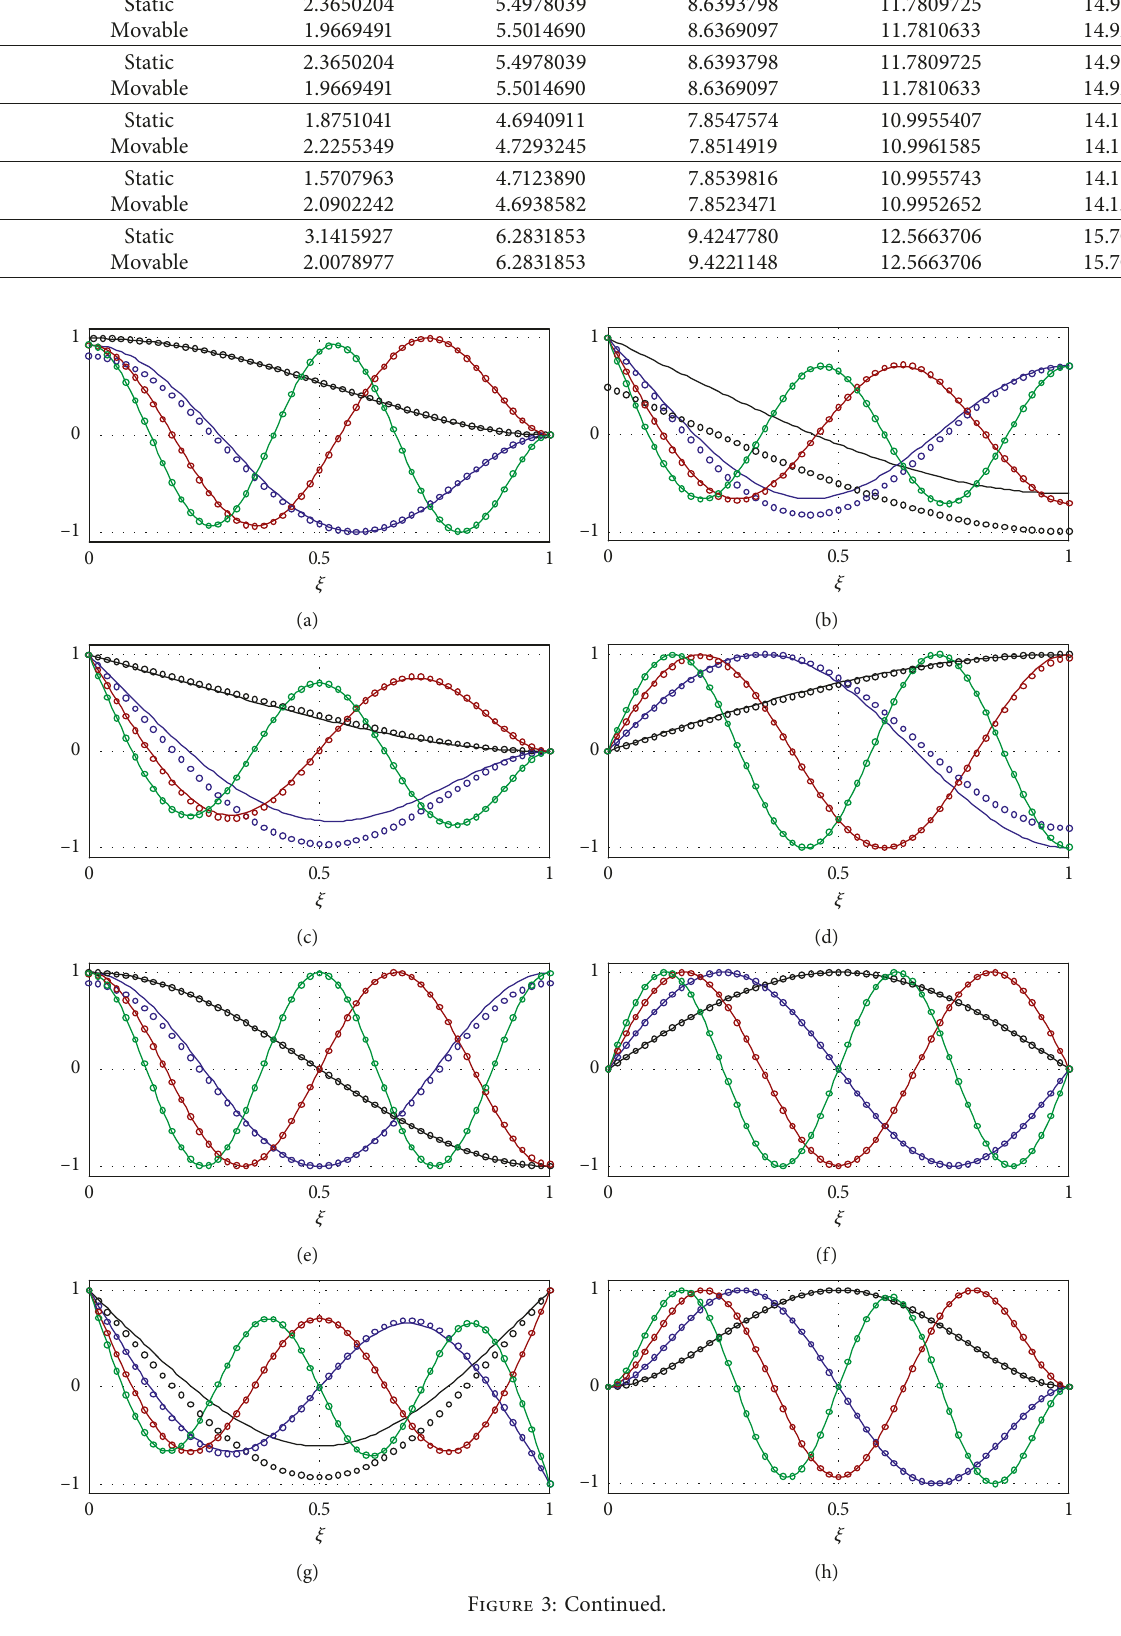
Table 4: First five numerical wave numbers ( a (cid:31) foundation of stiffness κ (cid:31)